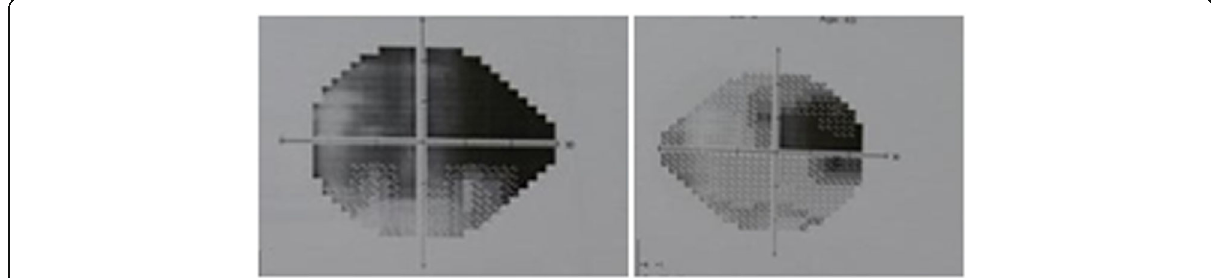
Fig. 4 Visual field improvement in the follow-up of the patient after 9 months. His visual field showed improvement as well as his visual